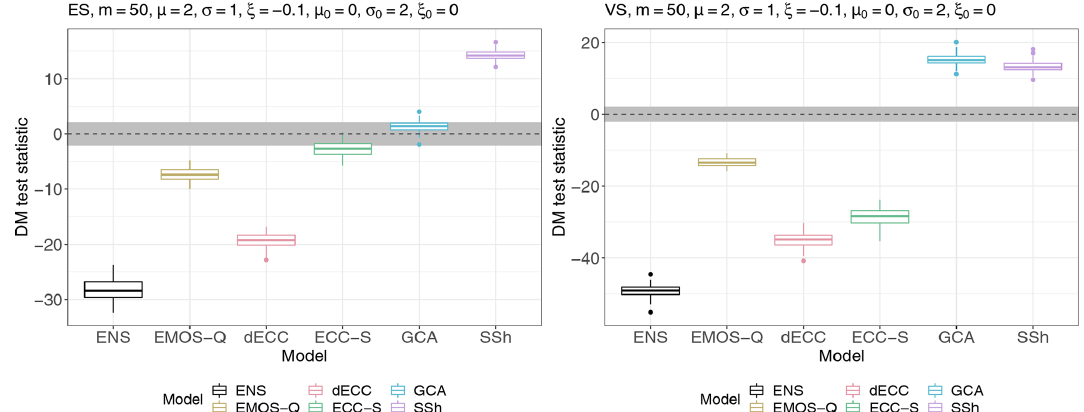
Figure 5. As Fig. 4 but based on ES and VS for (µ 0 ,ξ 0 ,σ 0 ) = ( 2 . 0 , − 0 . 1 , 1 . 0 ) , and (µ,ξ,σ) = ( 0 . 0 , 0 . 0 , 2 . 0 ) , where ρ 0 = 0 . 75 and ρ = 0 . 25, and ensemble size m =